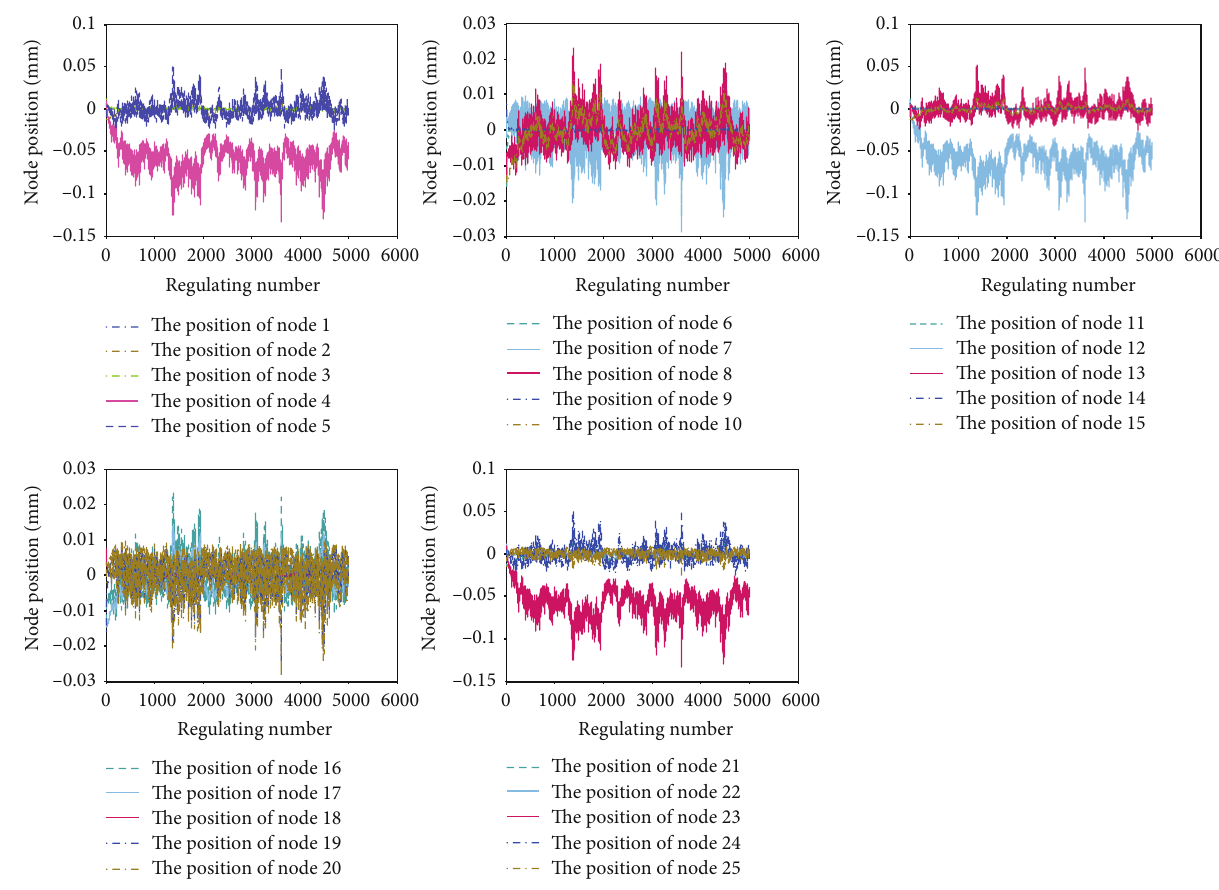
Figure 12: Training curve of value